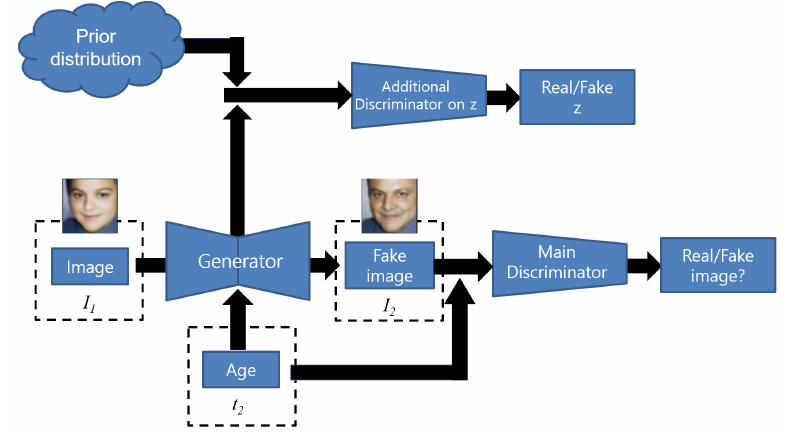
Figure 2. The baseline model based on Conditional Adversarial Autoencoder